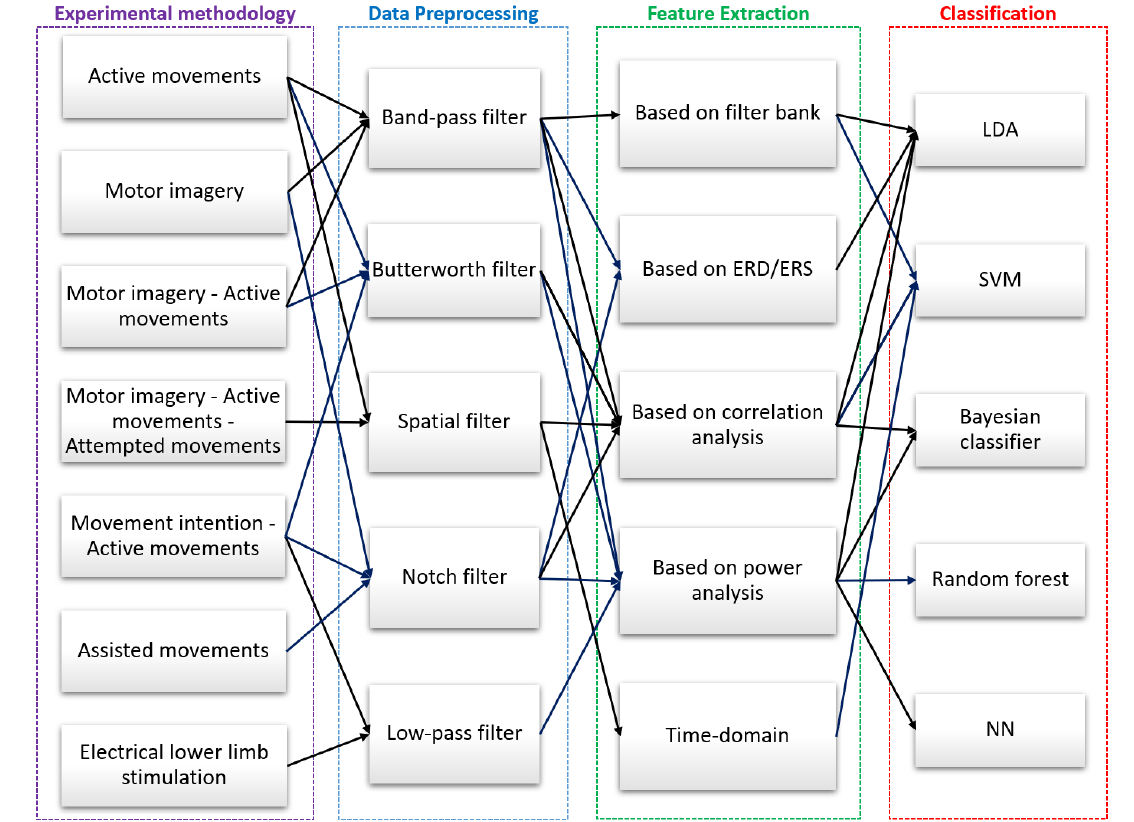
Figure 11. A joint flowchart summarizing the types of tasks and algorithms that have been used at each stage. Associated bibliographic references per task: Experimental methodology: active movements [59,67,72–74], motor imagery [61,63,64,70,75,78], motor imagery–active movements [71,76,77,79], motor imagery - active movements - attempted movements [80], movement intention– active movements [60,66,68,69], assisted movements [62], and electrical lower limb stimulation [65]; Data preprocessing: band-pass filter [63,70–73,76,77], butterworth filter [59,66,69,79], spatial filter [74,80], notch filter [62,68,75], and low-pass filter [60,65]; Feature extraction: based on filter bank [63,71], based on ERD/ERS [62,77], based on correlation analysis [59,68–70,73,74], based on power analysis [60,65,66,72,75,76,78,79], and time-domain [80]; Classification: LDA [60,68,69,71,77], SVM [63,70,74,80], bayesian classifier [59,78], random forest [66], and NN